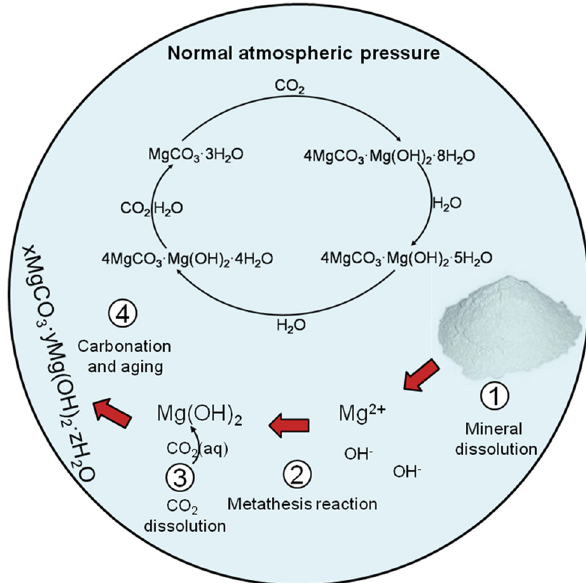
Figure 10: Schematic diagram of the production of magnesium carbonate hydrate with di ff erent morphologies during talc